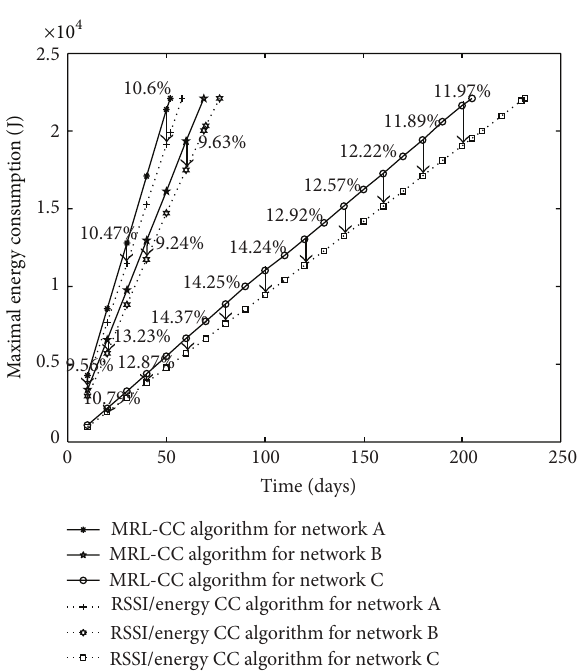
Figure 9: Maximal energy consumption in the whole WSN, com- parison between MRL-CC and E/RSSI-CC algorithms for different network architectures.